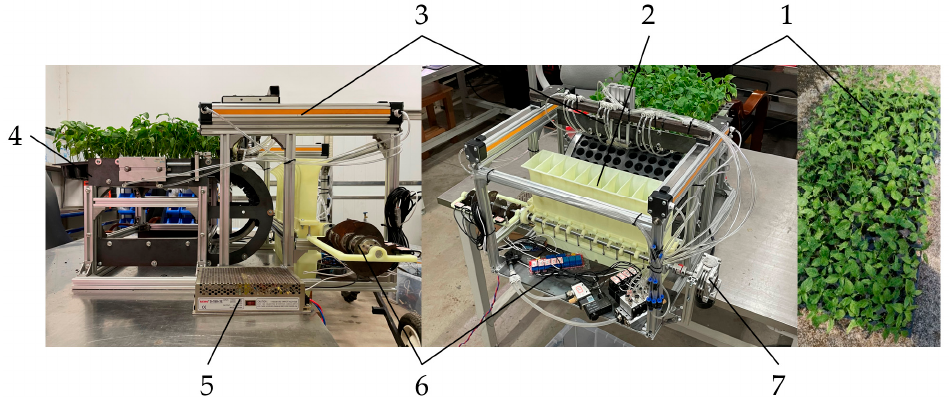
Figure 10. Prototype of automatic seedling feeding mechanism and pot seedling for testing: (1) pepper pot seedling, (2) interval seedling dropping mechanism, (3) pneumatic seedling pick ‐ up mechanism, (4) plate sending device, (5) 24 V switching power supply, (6) photoelectric controller and pneumatic control element, (7) drive motor.